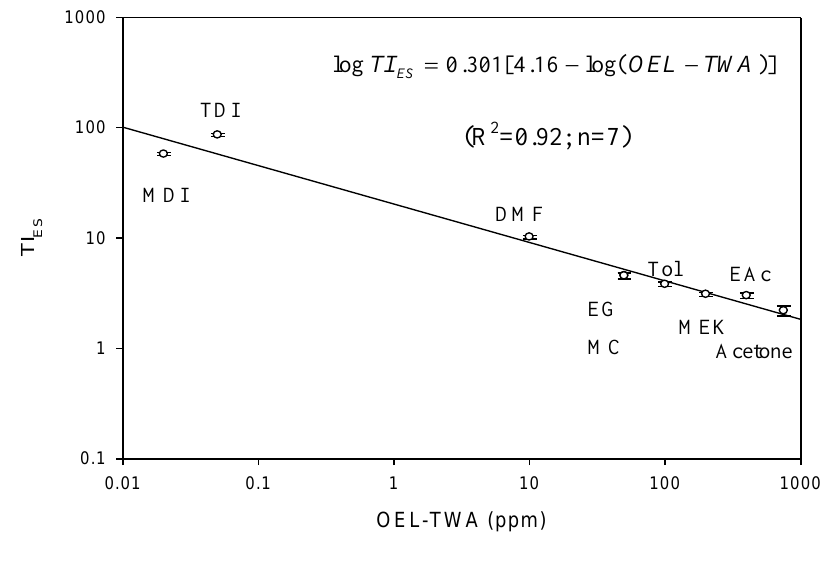
Figure 1. The relationship between TI corresponding